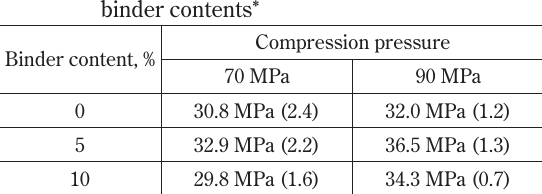
Table 4 Axial penetration strength of tablets made from dry powder formulations at 70 and 90 MPa compression pressures and